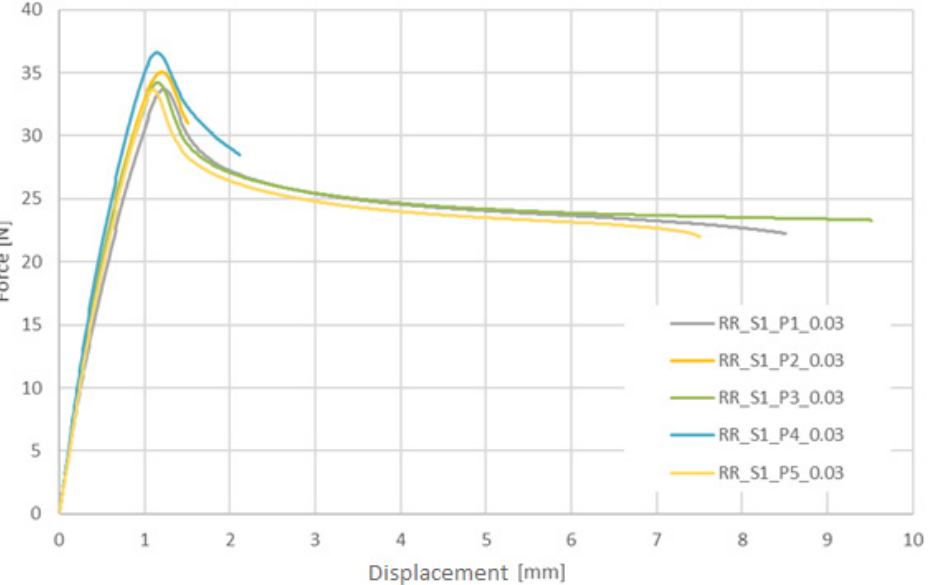
Figure 8. Longitudinal tensile force vs machine grip displacement for tubular specimens made of PLGA (assumed strain rate 0.03 1/s).